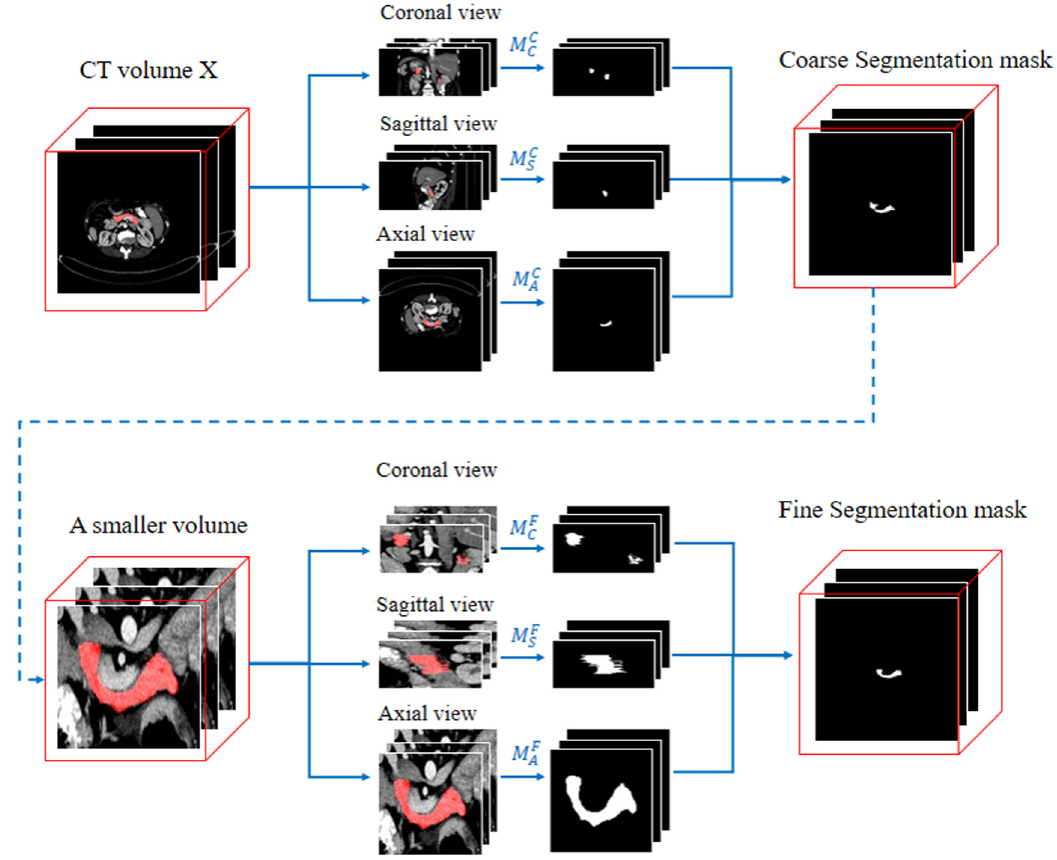
Fig 3. Illustration of the coarse-to-fine framework. The framework segments the pancreas through coronal, sagittal and axial viewpoints and fuses the results into a new segmentation volume.